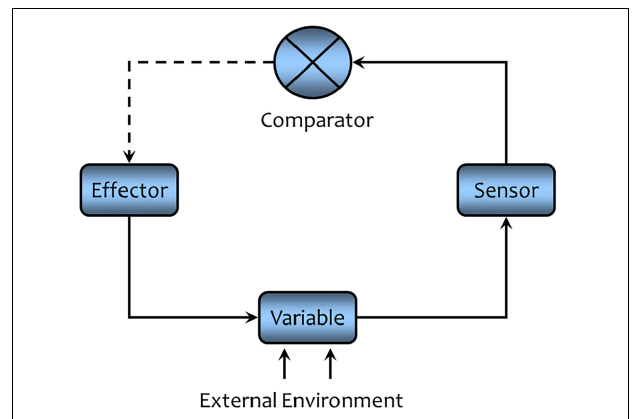
FIGURE 5 | A schematic representation of negative feedback regulation. A solid line indicates that the connected components are directly related (an increase in one component leads to increase the connected component, while a decrease will lead to decrease in the connected components). A dashed line indicates the connected components are inversely related (an increase in one component leads to a decrease in the connected component while a decrease will lead to an increase in the connected component). An odd number of dashed lines are a necessary condition for any negative feedback cycle of causation. Negative feedback acts to maintain the controlled variable within a narrow range of values (see text for a detailed description).